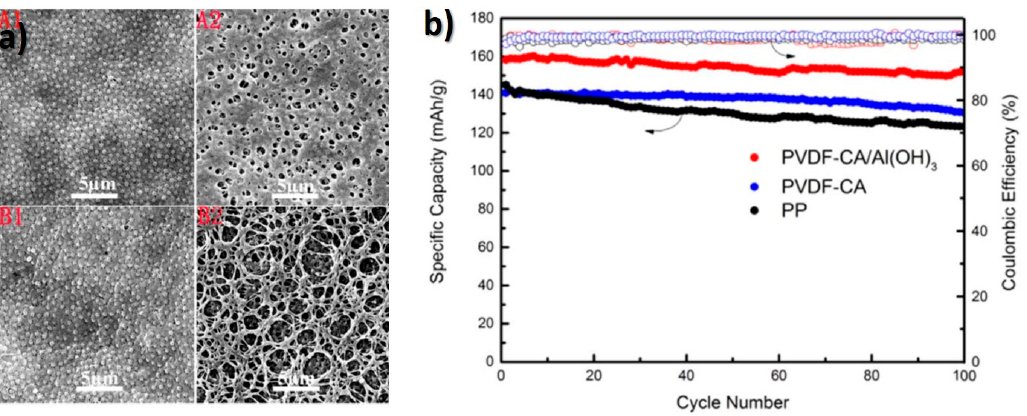
Figure 6. ( a ) SEM images of separators microstructure and ( b ) cycle performance of cells assembled [70], with copyright permission from Elsevier.